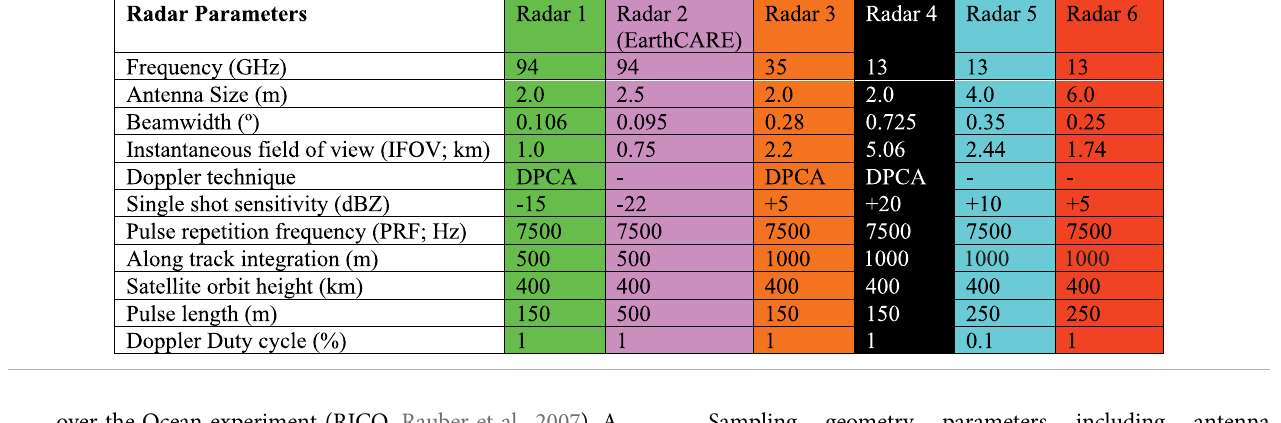
TABLE 1 | Technical speci fi cations for the six spaceborne radar architectures under